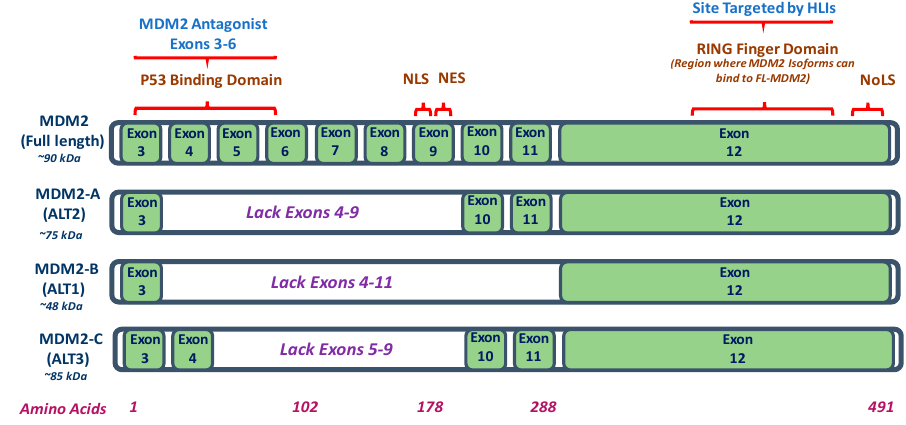
Figure 1. Illustrative Representation of MDM2-FL and MDM2 Isoforms (MDM2-A, MDM2-B, and MDM2-C). Adapted and modified from Huun et al. [5]. NES = nuclear export signal, NoLS = nucleolar localization signal, and NLS = nuclear localization signal.